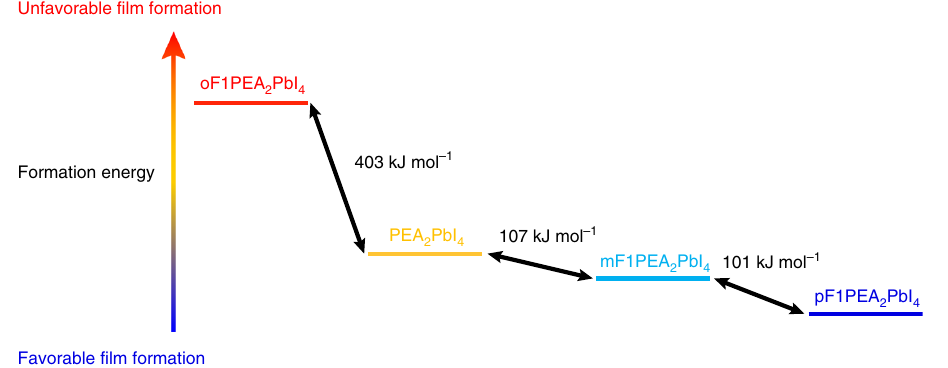
Fig. 6 Relative formation energy difference between different 2D OIHPs ( n = 1). DFT calculation of formation energy for PEA 2 PbI 4 , oF1PEA 2 PbI 4 , mF1PEA 2 PbI 4 , and pF1PEA 2 PbI